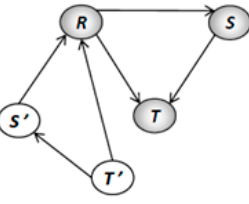
Figure 6. Pruning graph without strongly connected graph of Figure 5.